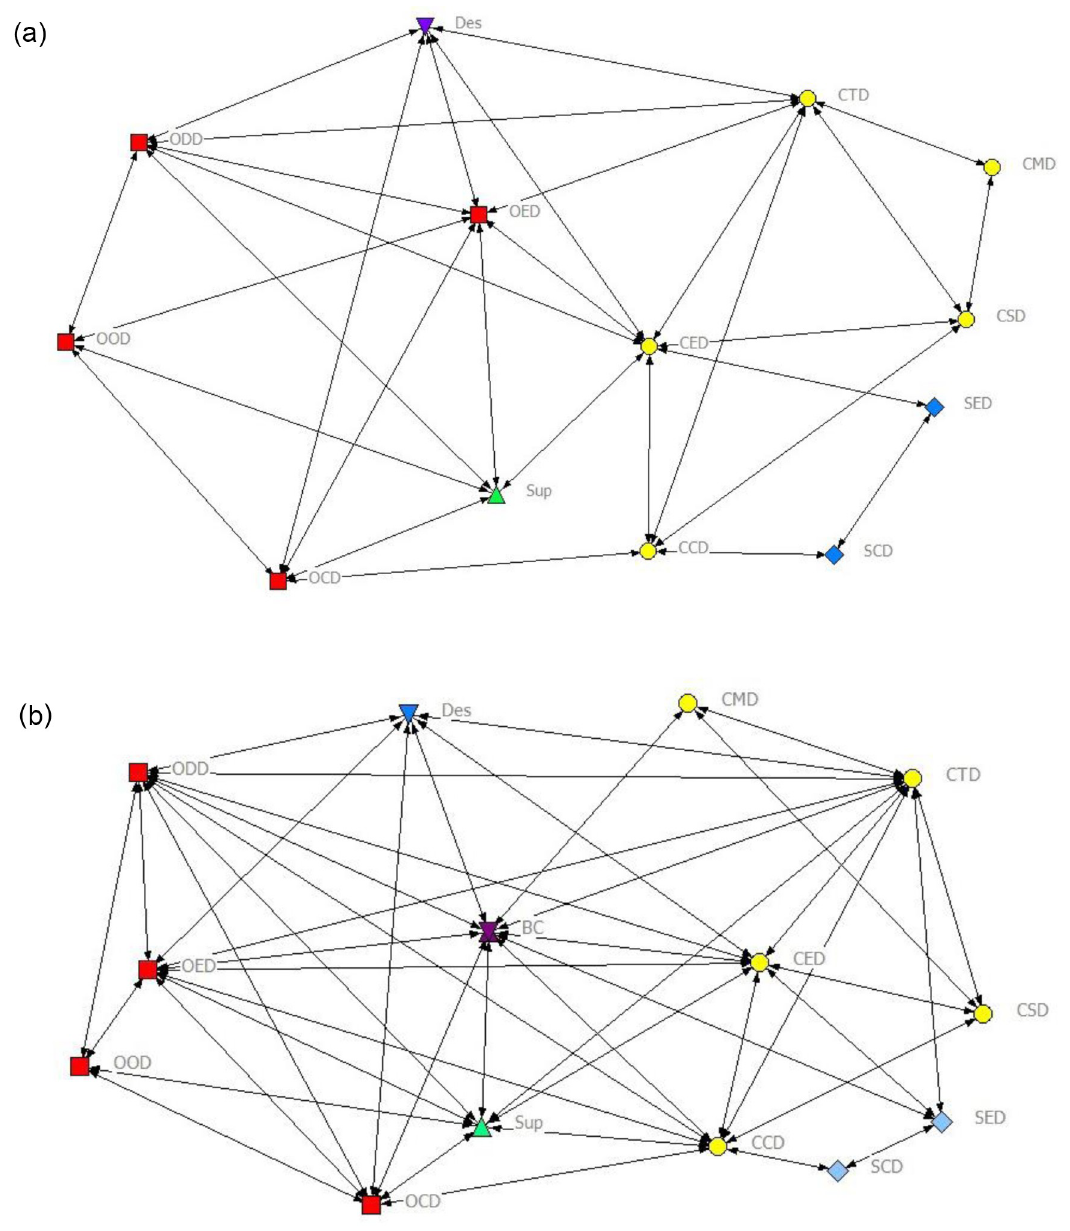
Fig 2. Communication networks of the project team. (a) Before BIM use. (b) After BIM